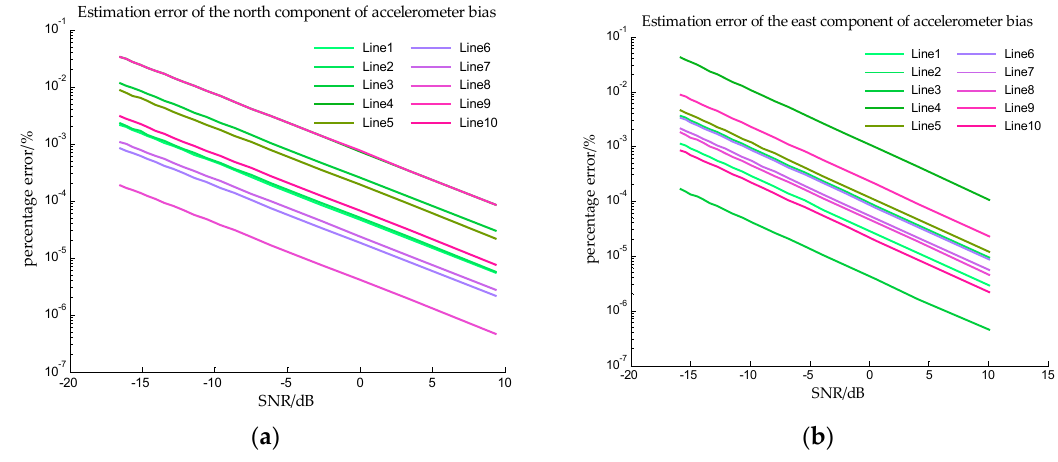
Figure 18. The estimation error of accelerometer bias on the short survey lines in simulation V. ( a ) Is the estimation error of the north component of the accelerometer bias, and ( b ) is the estimation error of the east component of the accelerometer bias.